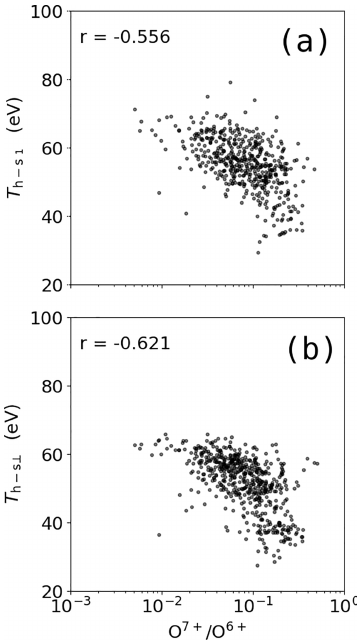
Figure 6. Scatter plots of E s against O 7 + / O 6 + for Carrington rotations (a) 2067 and (a) 2089. Pearson linear correlation coeffi- cients are printed on the plots. A weak positive relationship appears in (a) ( r = 0 . 627) which is absent in (b)